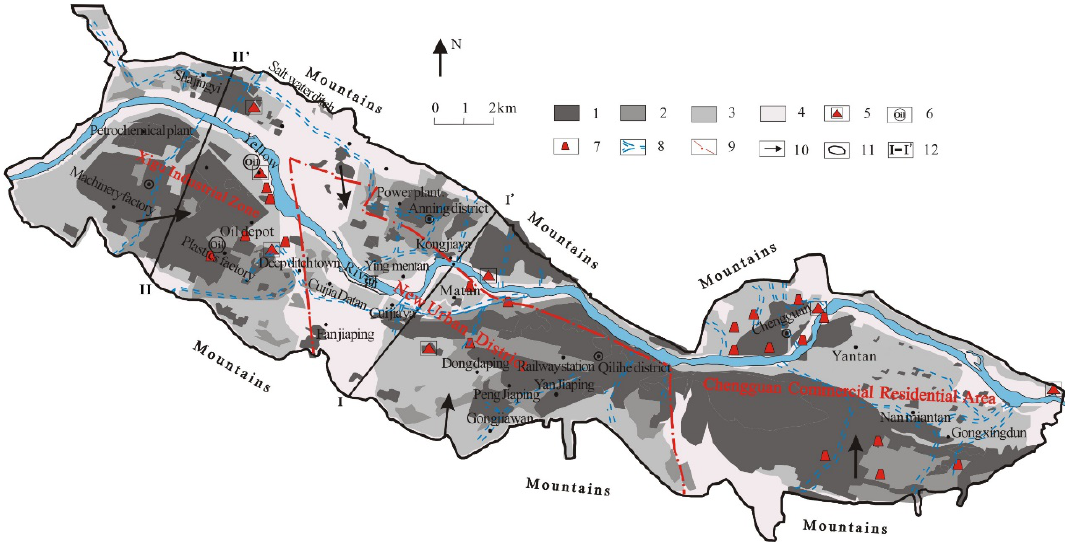
Figure 1. Urbanization expansion from 1980 to 2012 and distribution of pollution sources in study